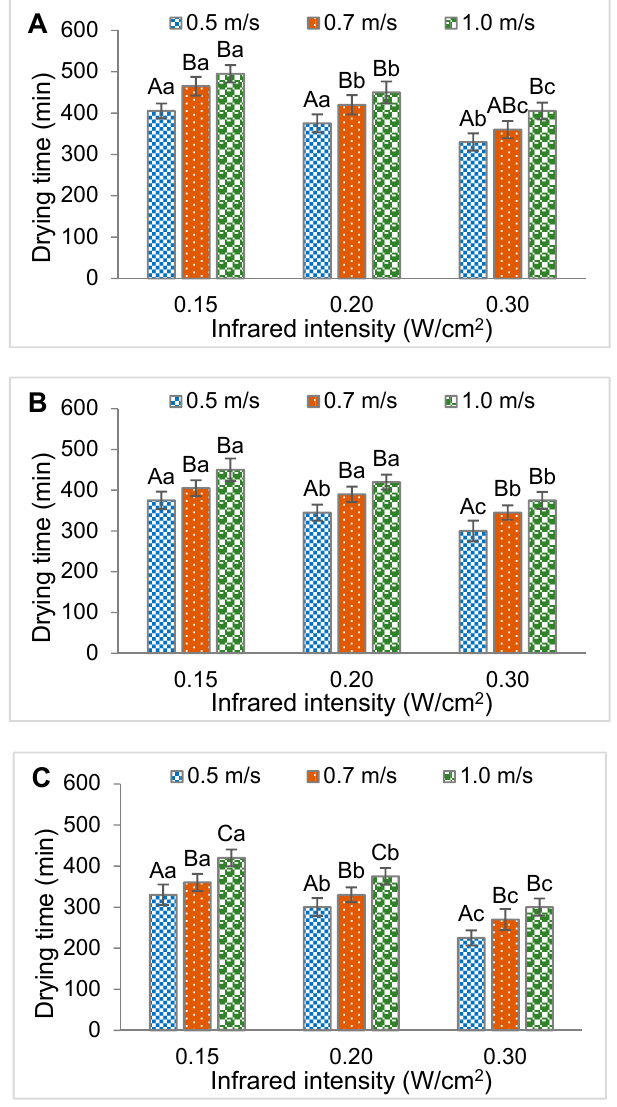
Figure 4. The e ff ect of infrared radiation intensity at di ff erent air velocities on the drying time using a combined dryer at 40 ◦ C ( A ), 50 ◦ C ( B ) and 60 ◦ C ( C ). The di ff erent capital letters at the same infrared intensity showed significant di ff erences, while di ff erent lowercase letters of the same series showed significant di ff erences (at P ≤